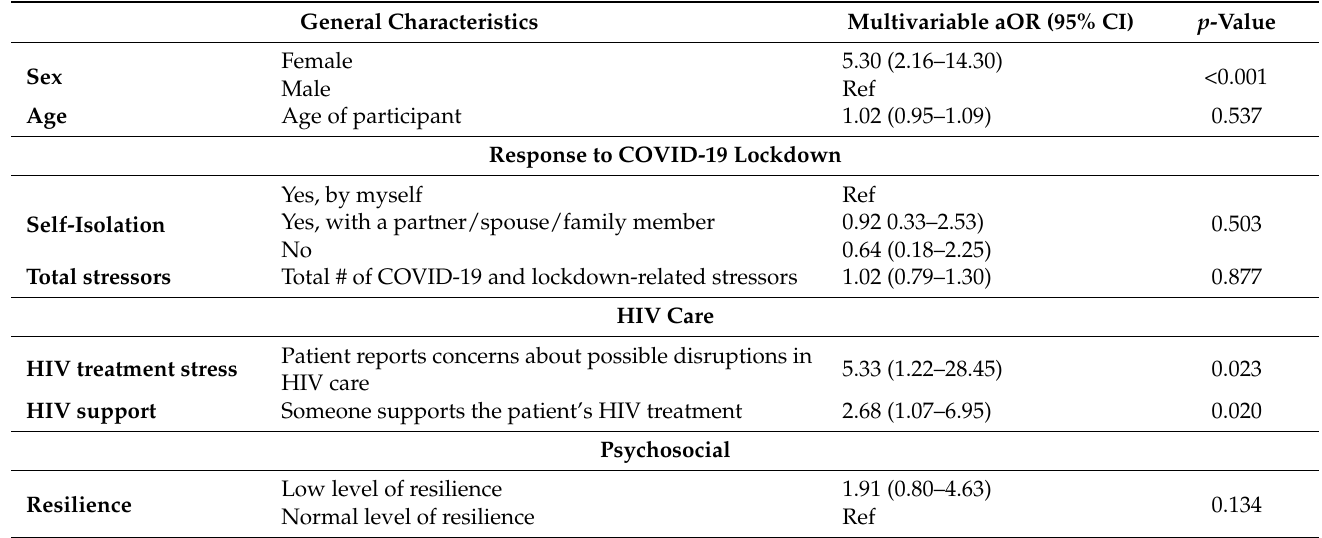
Table 4. Multivariate correlates of generalised anxiety disorder symptoms among OPWH in Ukraine (n = 123) 1